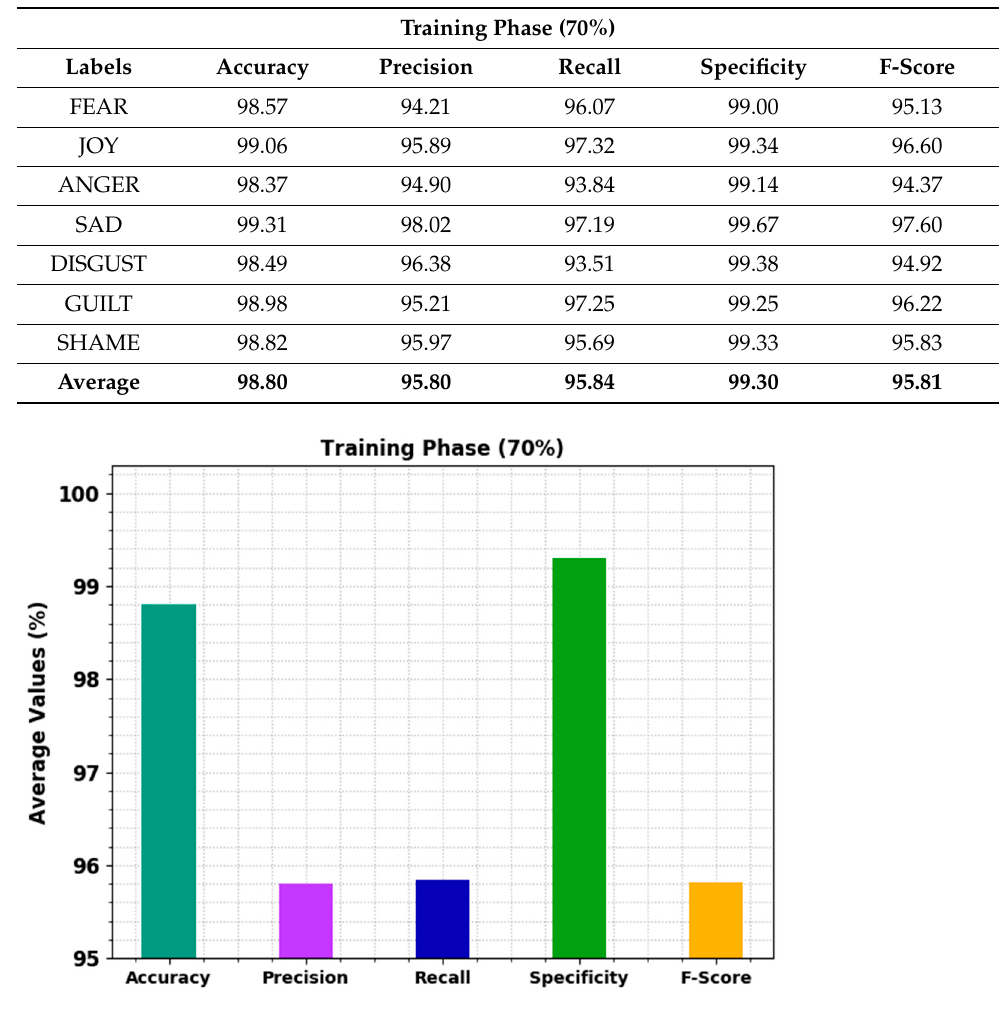
Figure 5. Result analysis of CLBEDC-SND approach under 70% of TR data. Table 4. Result analysis of CLBEDC-SND approach with distinct class labels under 30% of TS data. Testing Phase